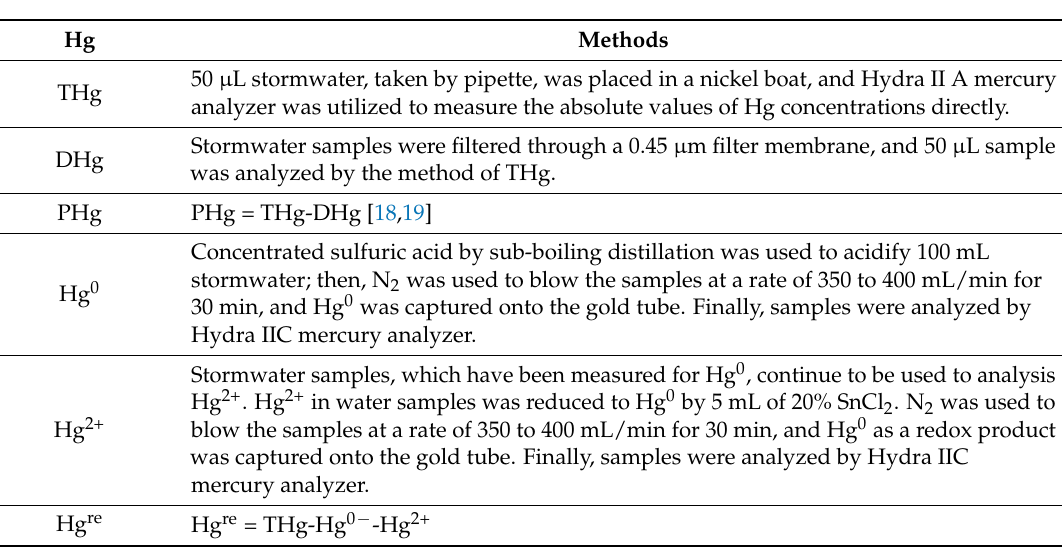
Table 3. Analytical methods of different Hg